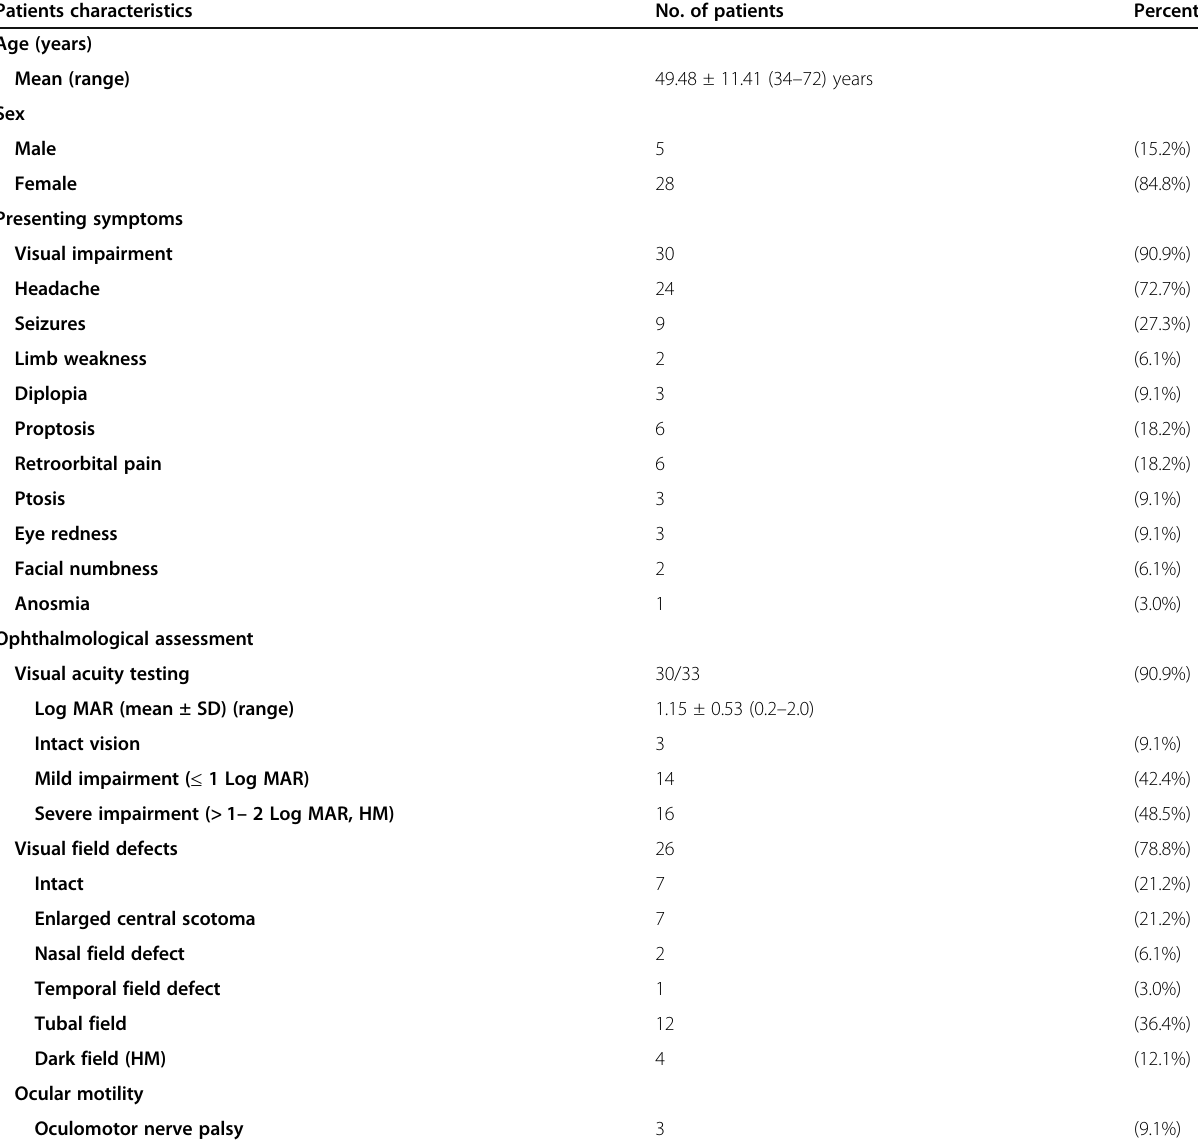
Table 1 Demographic and clinical data of 33 patients with ACMs Patients characteristics No. of